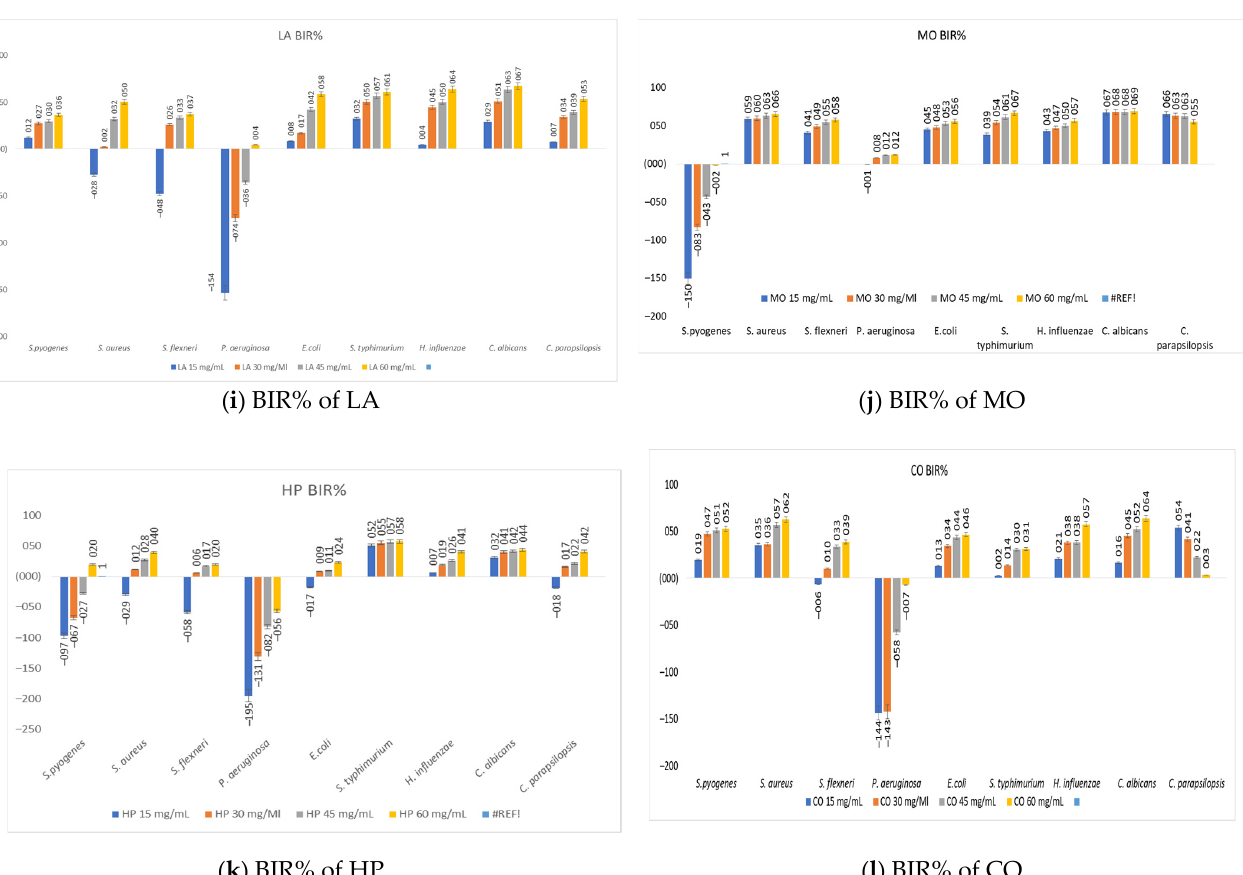
Figure 9. The antimicrobial activity of the extracts Regarding the antimicrobial effect of the MP extract (Figure 9a), the trend is posi-